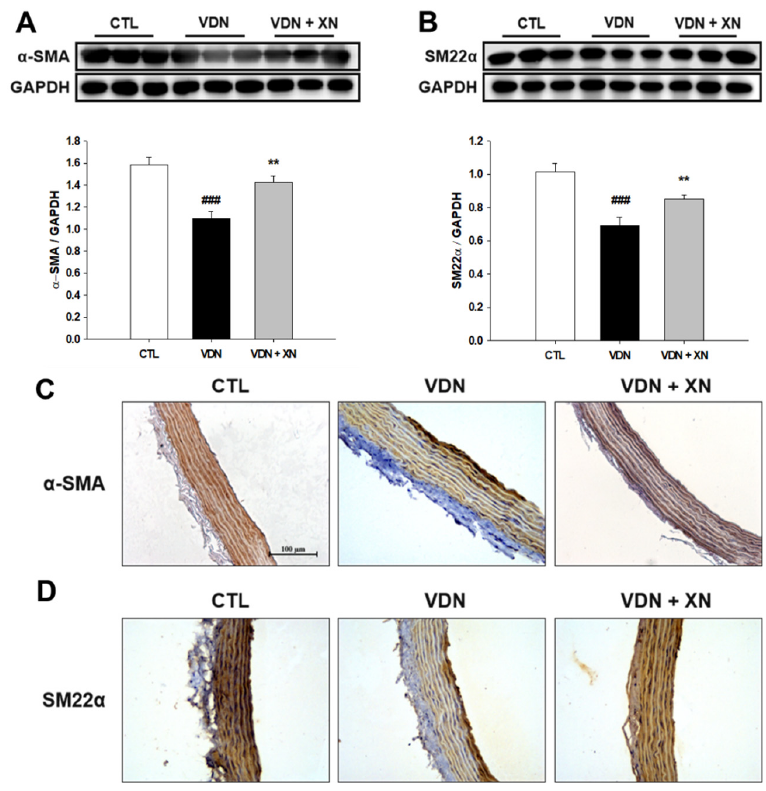
Figure 6. Effect of XN on vascular contractile phenotype markers. Western blot assay of ( A ) α -SMA and ( B ) SM22 α . GAPDH was a control for protein loading. Results were obtained from six independent experiments, and densitometric analysis of autoradiograms is shown as ratio to GAPDH. Immunohistochemical staining to detect the expressions of ( C ) α -SMA and ( D ) α -SMA (200× magnification). Each point represents the mean ± SEM, n = 10. ### p < 0.001 compared with the control group. ** p < 0.01 compared with VDN group.